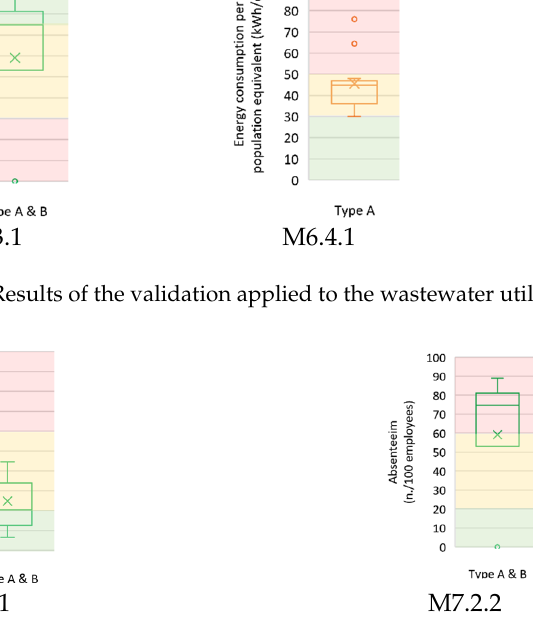
ities in the validation have a result of good.